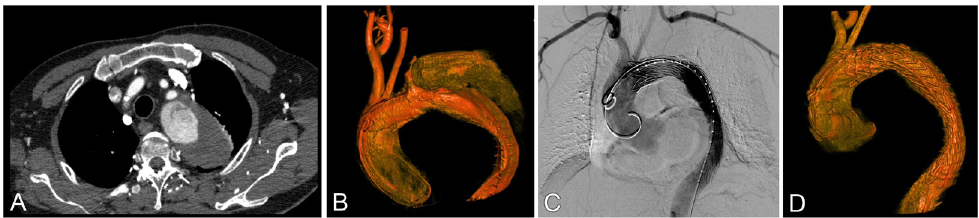
Fig. 3 - Carotid-left subclavian graft with prosthesis anchoring in Zone 2. A=Angiotomography in axial section showing massive thoracic aneurysm without proximal landing zone. B=Three-dimensional reconstruction of pre-implanted stents. C=Digital subtraction angiotomography with endoprosthesis anchoring in Zone 2 and carotid-suclavian patent graft. D=Three-dimensional angiographic reconstruction after stent implantation without